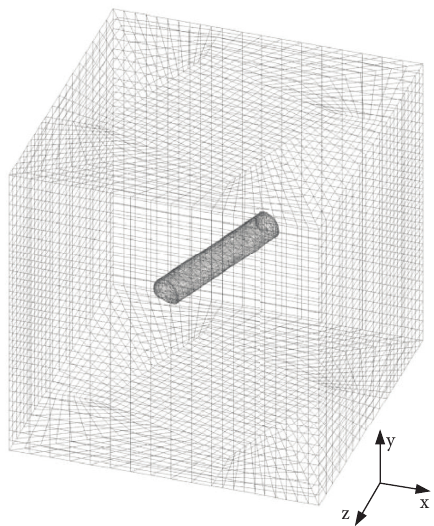
Figure 4: Meshed model ( φ � 20 ° ).